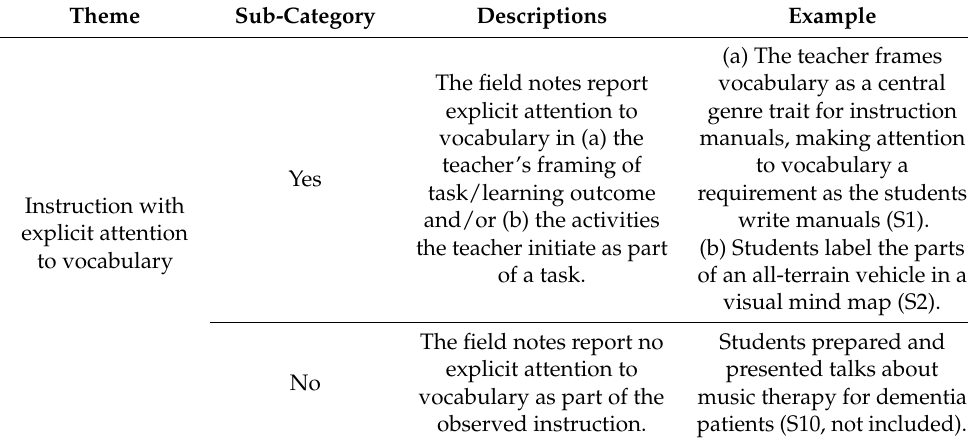
Table A1. Coding scheme with